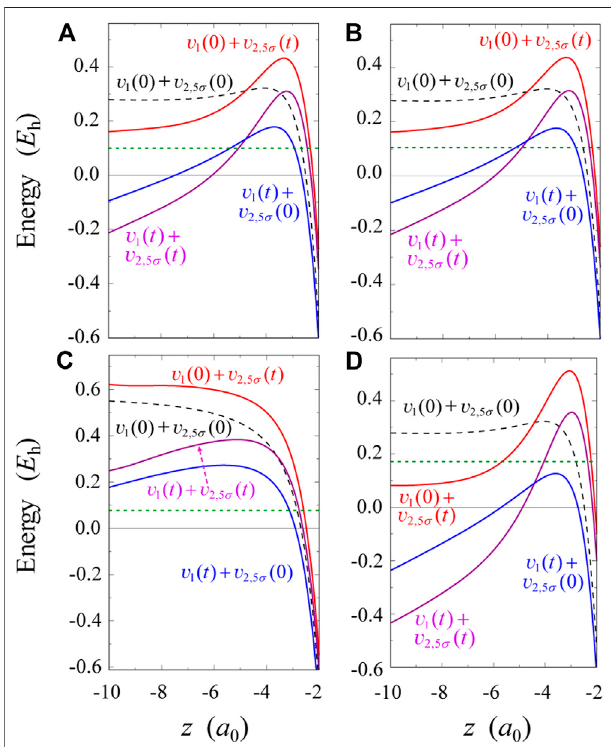
FIGURE 2 | Four kinds of 5 σ effective potentials plotted parallel to the z -axisatthe fi xedvalueof ρ (cid:2) 0.755 a 0 : (A) potentialsobtainedbyTD-CASSCF at t (cid:2) t 1 ≈ 2 fs under the interaction with ε 1 ( t ) in Figure 1A ; (B) TD-CASSCF potentials at t ≈ 2.53 fs for ε 2 ( t ) in Figure 1B ; (C) TDHF potentials at t (cid:2) t 1 ≈ 2 fs for ε 1 ( t ) , i.e., the same pulse as in Figure 1A ; (D) TD-CASSCF potentials at t (cid:2) t 1 ≈ 2 fs for the pulse (15) with a higher strength of F T (cid:2) 0.06 E h /( ea 0 ). υ 1 ( t ) and υ 2 , 5 σ ( t ) are respectively the one-body part and two- body part in υ eff 5 σ ( t ) . In each panel, the black broken, blue, red, and purple lines denote υ 1 ( 0 ) + υ 2 , 5 σ ( 0 ) , υ 1 ( t ) + υ 2 , 5 σ ( 0 ) , υ 1 ( 0 ) + υ 2 , 5 σ ( t ) , and υ eff ( t ) (cid:2) υ ( t ) + υ ( t ) , repectively. For reference, the level of the effective 1 2 , 5 σ 5 σ orbital energy E 5 σ ( t ) is given by a green horizontaldotted line. The time point t at which the effective potentials are calculated is indicated by a red fi lled circle in each panel in Figure 1